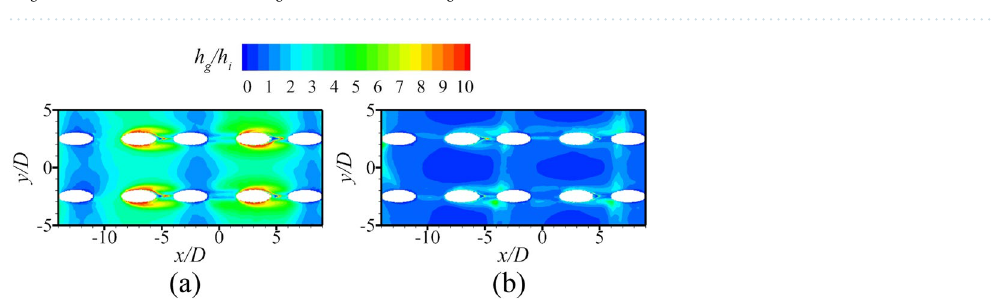
Figure 28. Contours of h g / h i for different cases. ( a ) Ref-case #1 (smooth); ( b ) Ref-case #2 (smooth-imp).